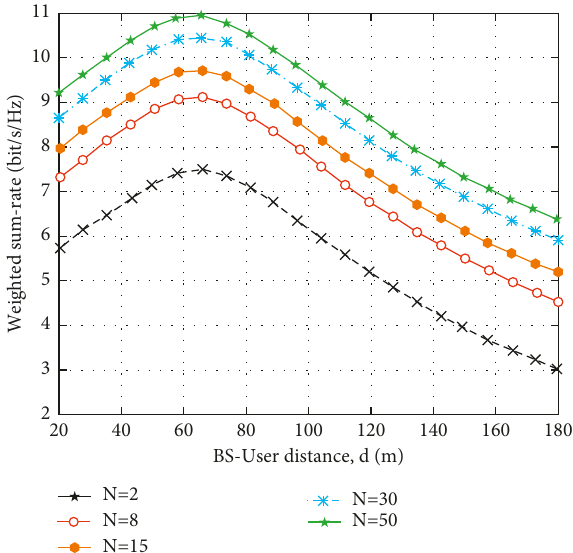
Figure 5: Change curve of achievable rate with